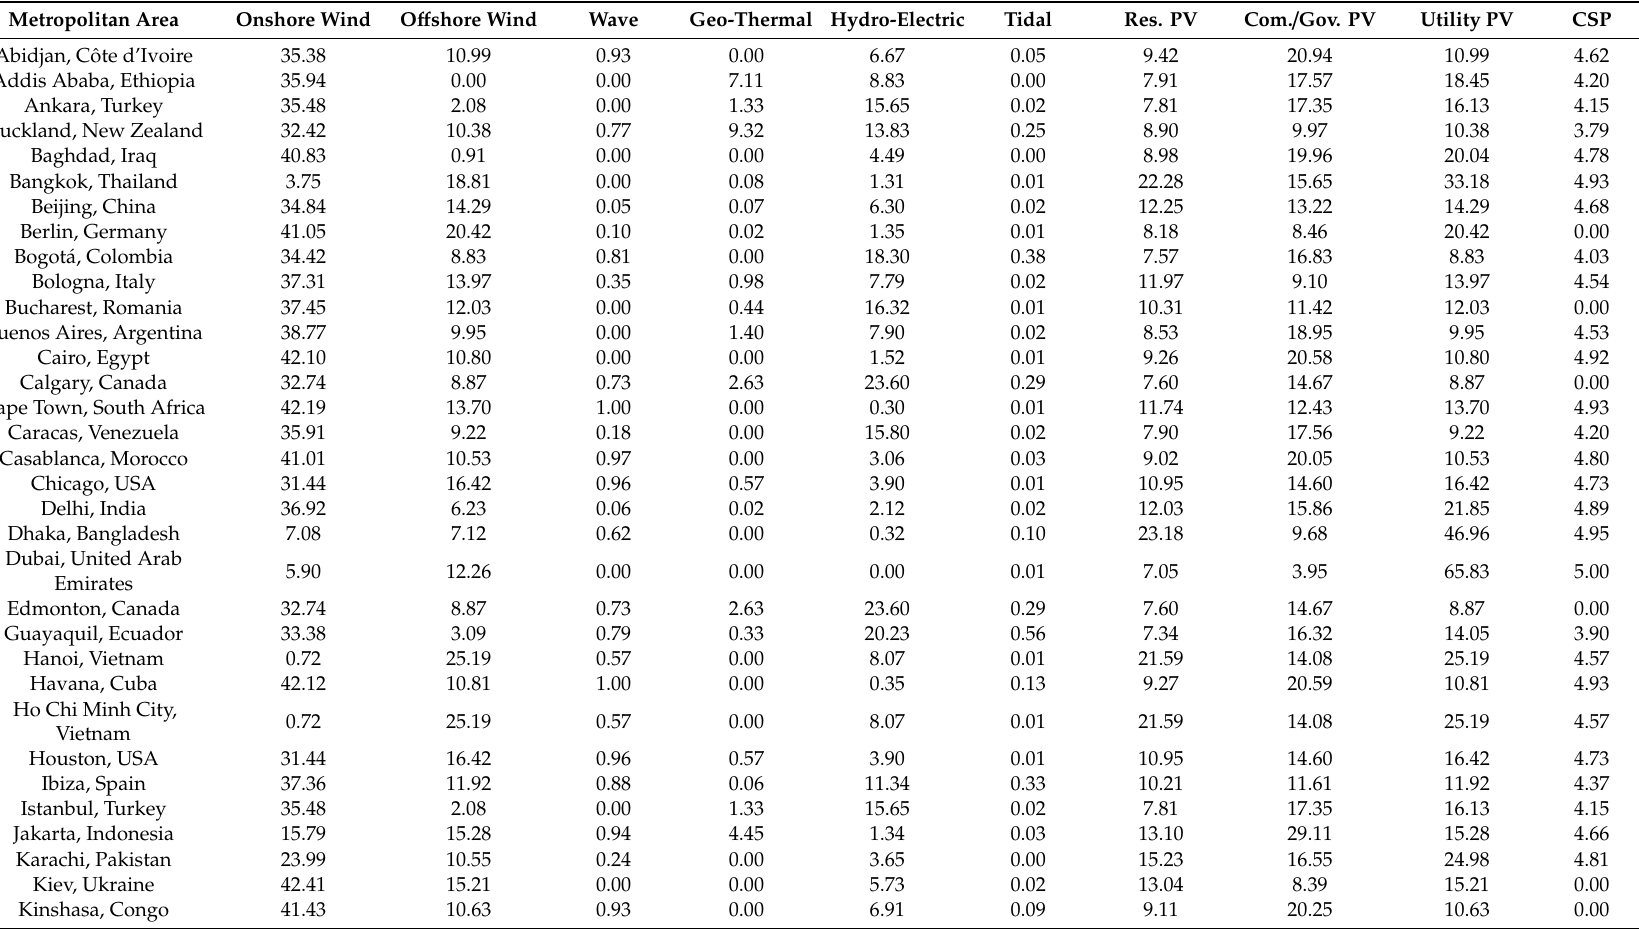
Table 3. Percent of the annually averaged 2050 metropolitan area all-purpose end-use WWS load (not nameplate capacity) in Table 1 to be met with the given type of electric power generator. Each row sum to